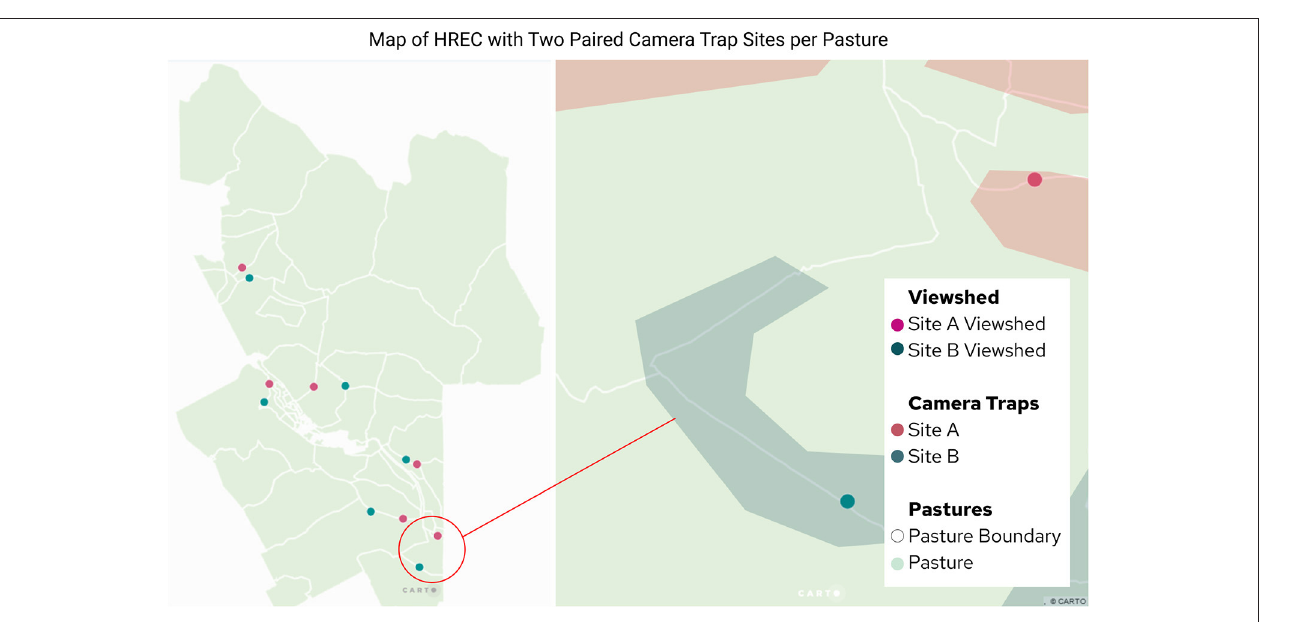
FIGURE 2 | Map of HREC with two paired camera trap sites per pasture. Each pasture’s Foxlight was alternated between two sites every 5 weeks, and a camera trap was placed at each site to continuously monitor coyote activity throughout the phase. Each phase was composed of two 5 week periods (such that within a given phase, each camera trap site had 5 weeks with a Foxlight, and 5 weeks without a Foxlight). In the figure, “viewshed” represents the areas of the pasture that were in the line-of-sight of the Foxlight when it was active. It was not possible to view a Foxlight in one site from any other. Image produced on